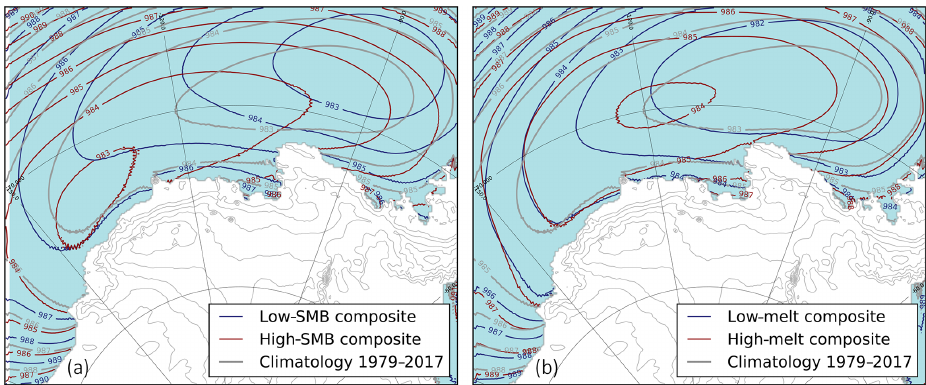
Figure 8. Summer sea surface pressure composites for high–low SMB (a) and high–low surface melt (b) . The ice sheet height is indicated by thin grey contours (every 500m). Table 2. Annual SMB decomposition for all drainage basins over 1979–2017 with SMB = snowfall + rainfall − sublimation − runoff. The middle rows indicate other terms that are not directly part of the SMB. The last two rows give snowfall and melt rates averaged over the ice